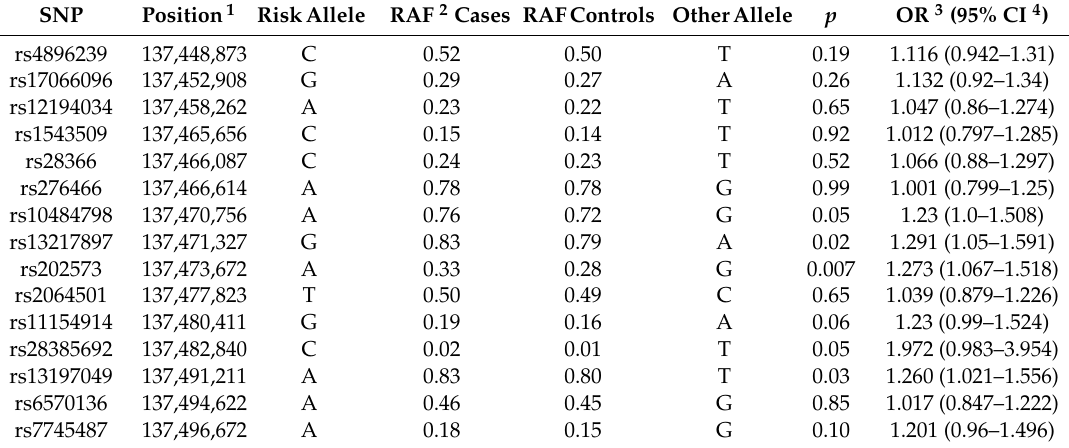
Figure 1. A single nucleotide polymorphism (SNP) screen of the IL22RA2 locus in the Bilbao dataset. SNPs, depicted with dots in different colors depending on r 2 values with respect to the index SNP rs202573, are plotted as a function of their log-converted p -value (left Y axis) and their position on chromosome 6 according to hg19 assembly of the human genome (X axis). The recombination rate across the locus is provided on the right Y axis. The red line represents the significance threshold ( p = 0.05). SNPs genotyped in the primary screening [3] are shown in italics. rs202573, which was genotyped both in the previous and in the present study, is underlined. Table 2. Association values of SNPs included in the mapping analysis in the Bilbao dataset. 1 Position is according to the hg19 genome build. 2 RAF: risk allele frequency. 3 OR: odds ratio. 4 CI: confidence interval.